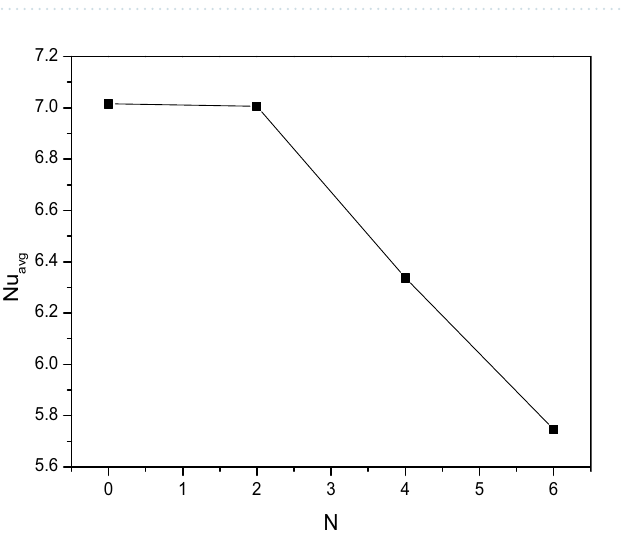
Figure 25. Variations of the streamlines ( (cid:31) ) and isotherms ( T ) with N at Ra = 10 6 , Ha = 0 , Da = 0.01 , ε = 0.2 , ω = 0 and φ = 0.02 .